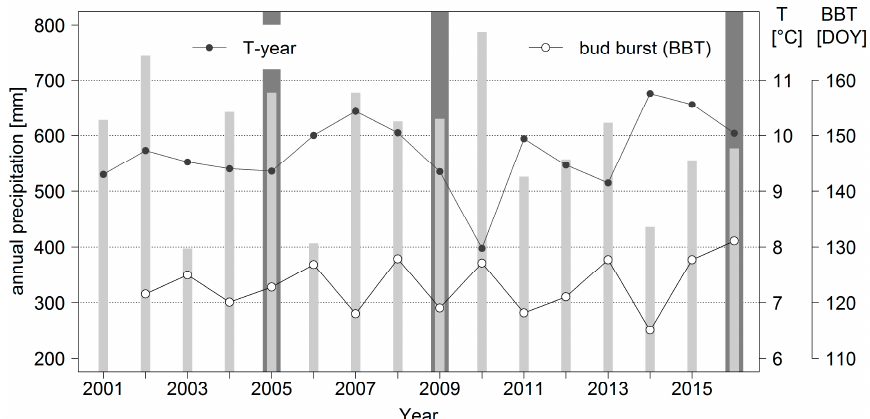
Figure 6. Annual sum of precipitation (bars), mean annual temperature (T-year), day of pine bud burst (BBT; DOY = Day Of Year), and years of mass outbreaks (dark grey columns) in the study area from 2001 to 2016. BBT was modeled from climate data according to Menzel [30]. Climate data originate from the German Weather Service station at Doberlug-Kirchhain in the center of the study region.